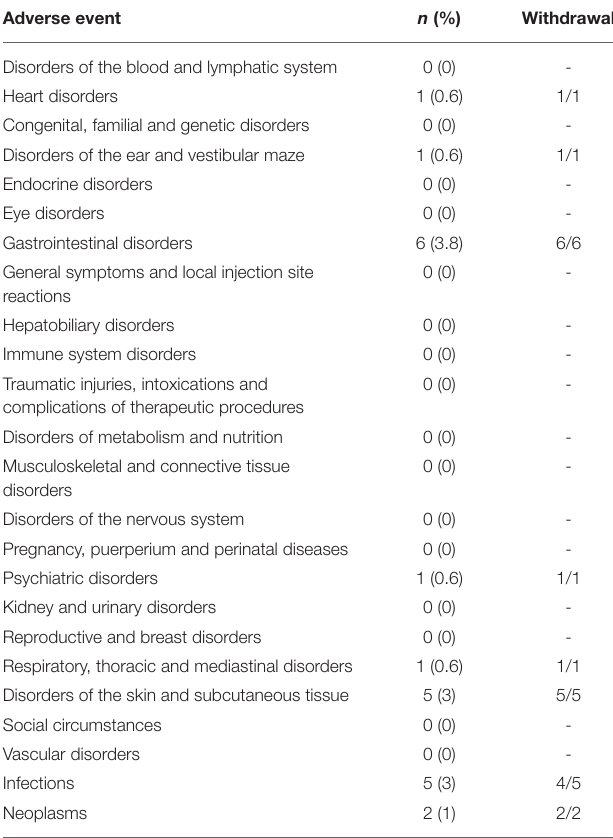
TABLE 2 | Description of adverse events